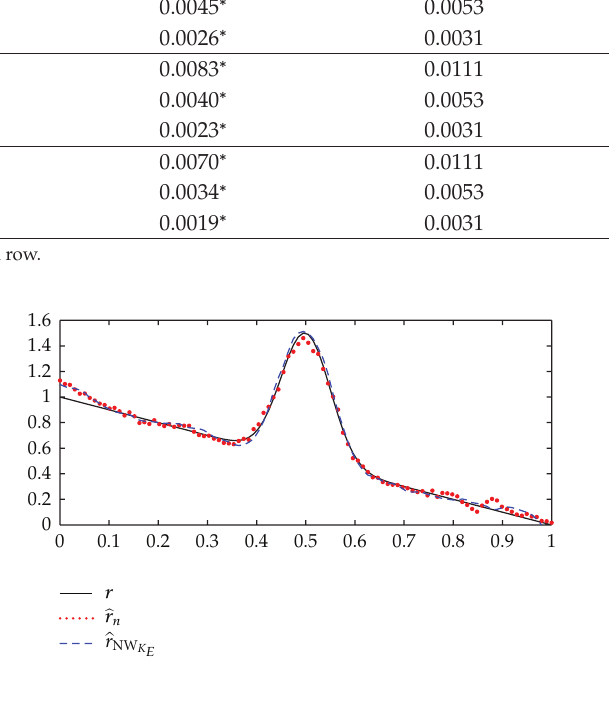
Figure 1: Estimation of r with (cid:2) r n and (cid:2) r